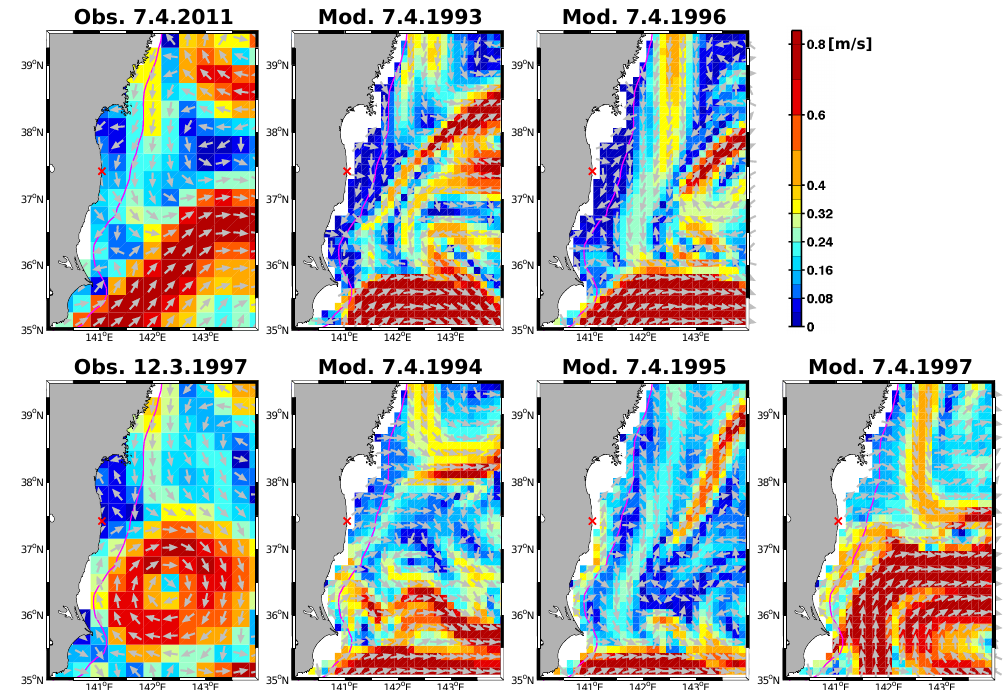
Fig. 6. Surface velocities at dates indicated by respective panel titles. The color shading denotes absolute velocity. The arrows indicate the direction of the currents. The magenta line is the 200m isobath, the red cross marks the nuclear power plant. The first column of panels (titled “Obs. 7.4.2011” and “Obs. 12.3.1997”) shows geostrophic velocities as estimated from space (Aviso, CNES). The subsequent panels titled “Mod. ...” refer to simulated currents. The upper and lower row of panels feature typical, contrasting states of the circulation, respectively (see